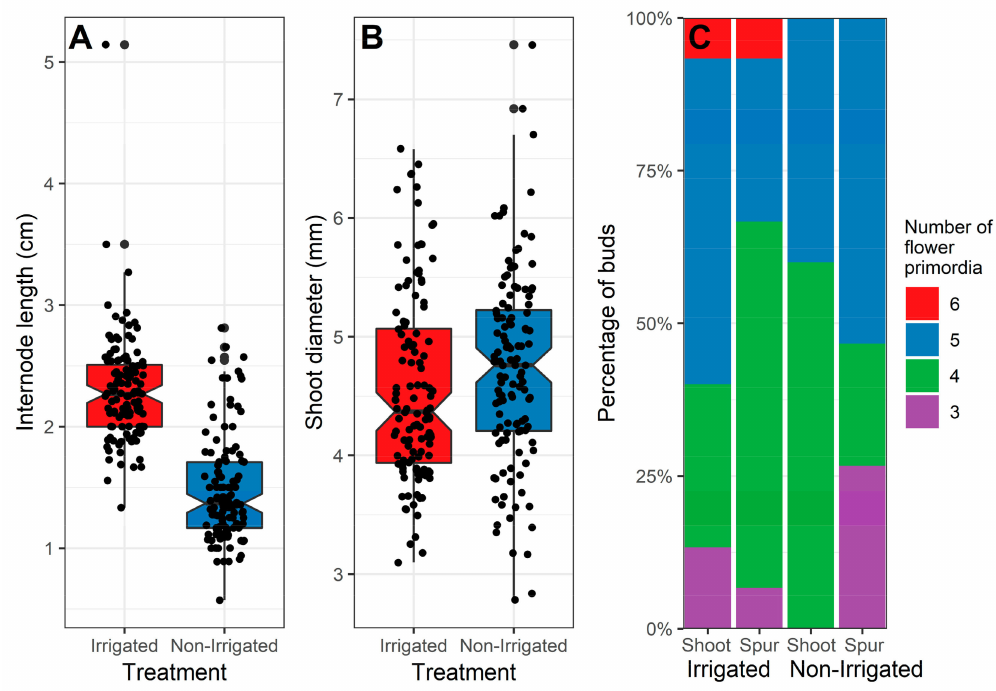
Figure 3. Morphological traits of one-year-old apple shoots cv. ‘Elstar’ sampled during the winter season of 2018 / 2019 (Table 1). Shoots were sampled from trees grown in Campus Klein-Altendorf, exposed to two water regimes during the growing season of 2018. ( A ): Internode length. ( B ): Shoot diameter. In ( A ) and ( B ), boxplots represent the distribution of the data, while black dots represent actual observations. In boxplots, the colored box represents 50% of the data (percentile 25%, 50%, and 75%), whereas vertical black lines mean the distance between the percentile (25% or 75%) and the smallest or largest value, respectively. Notches represent an approximation of the 95% confidence interval for comparing medians. In total, 240 shoots were sampled for internode length and shoot diameter measurements. ( C ): Percentage of buds with a given number of flower primordia per cyme (colors) in one-year-old shoots and spurs considering 60 apical buds in